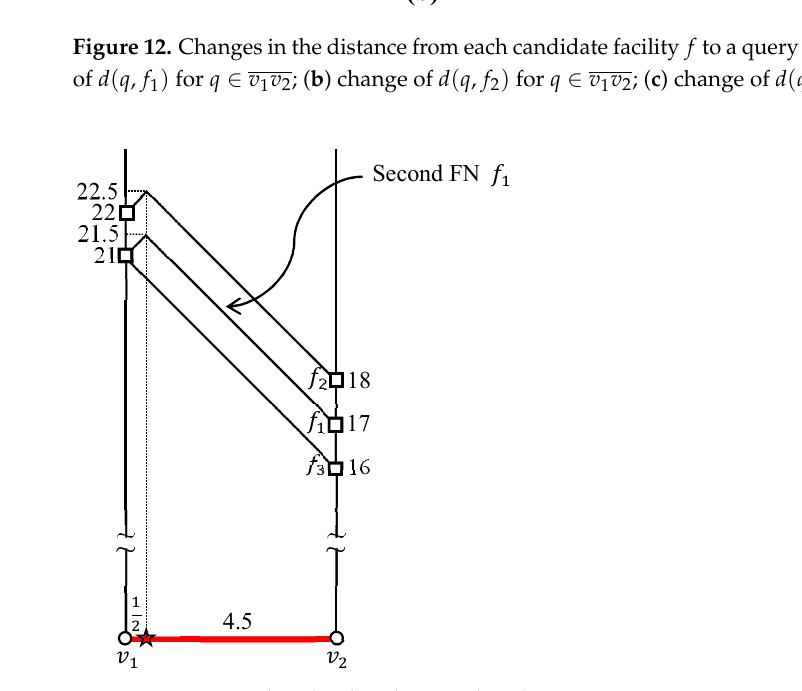
Figure 13. Plot of d ( q , f 1 ) , d ( q , f 2 ) , and d ( q , f 3 ) for q ∈ v 1 v 2